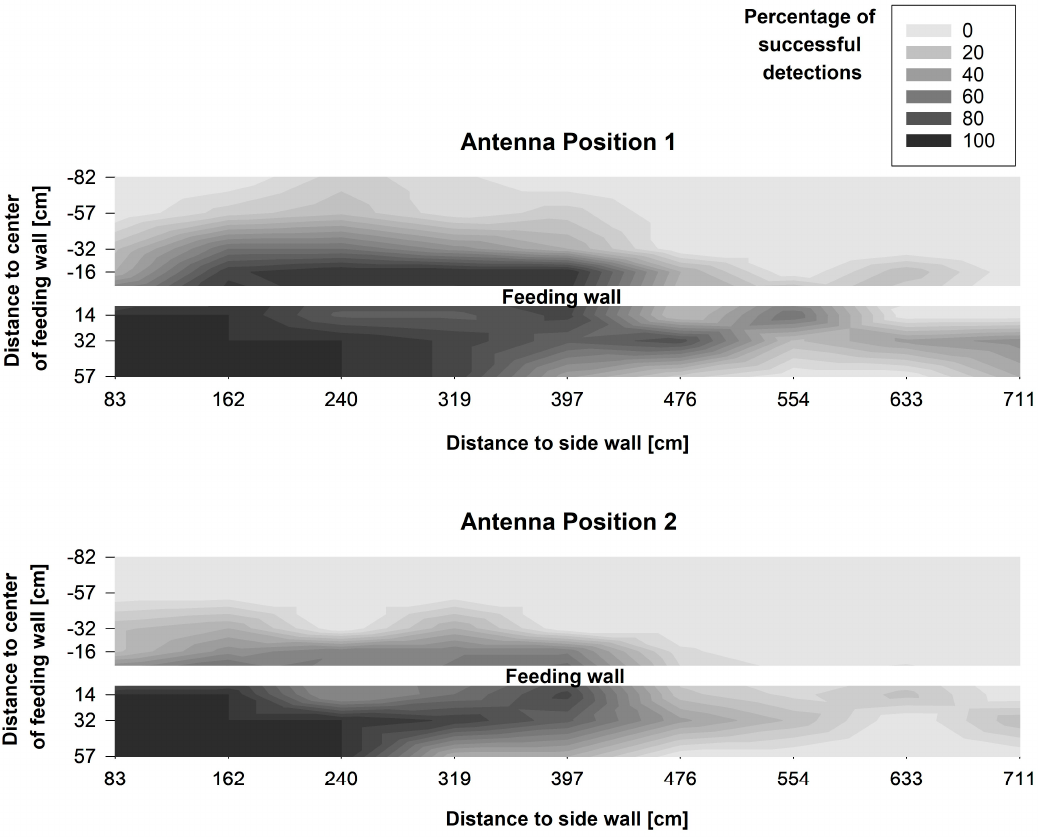
Figure 7. Interpolated contour plot showing the percentage of successful detections per coordinate of UHF ear tag Type B over all heights and for both antenna positions. Major ticks on the x- and y-axes indicate the measurement coordinates. Each x-coordinate represents the centre of a feeding place along the feed fence.